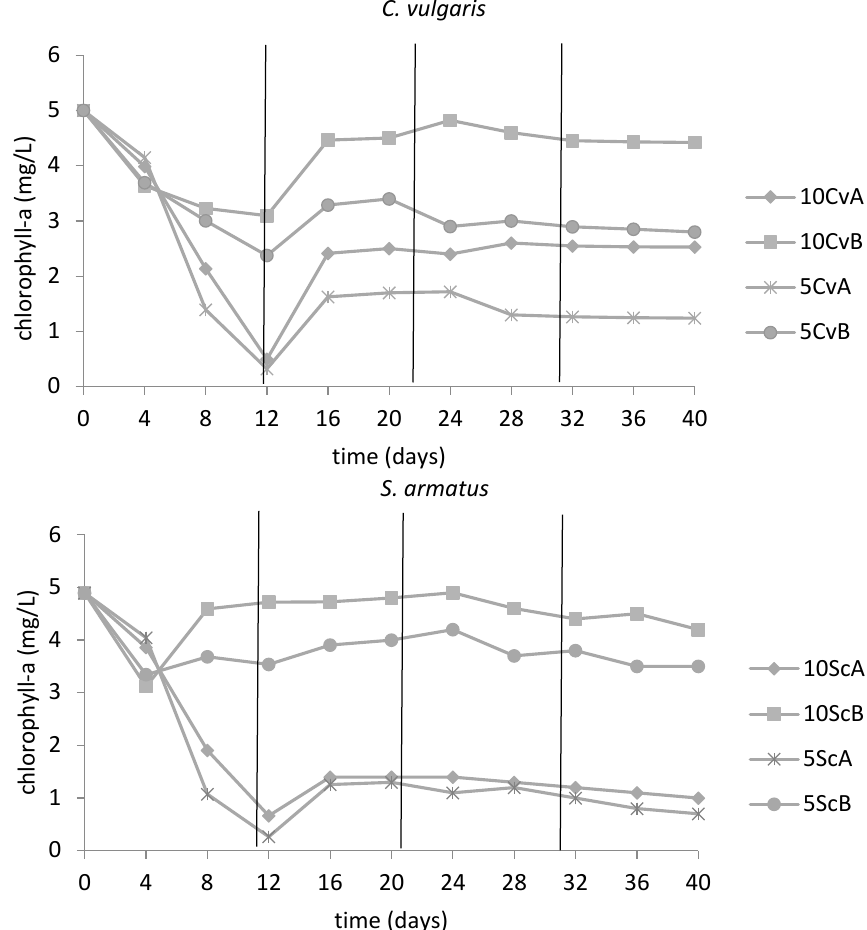
Figure 5. Chlorophyll-a concentration observed during the repeated fed-batch culture cultivation of microalgae. The lines indicate the days when the culture was fed with a new dose of wastewater.